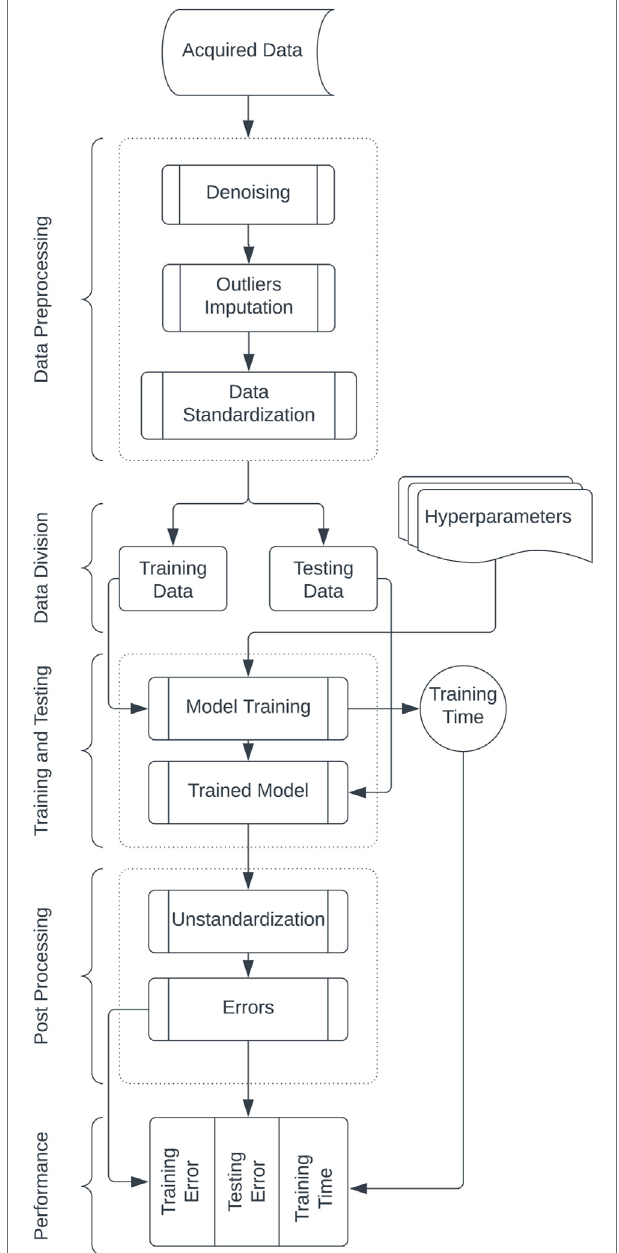
FIGURE 4 | Flowchart of the model development for NOx